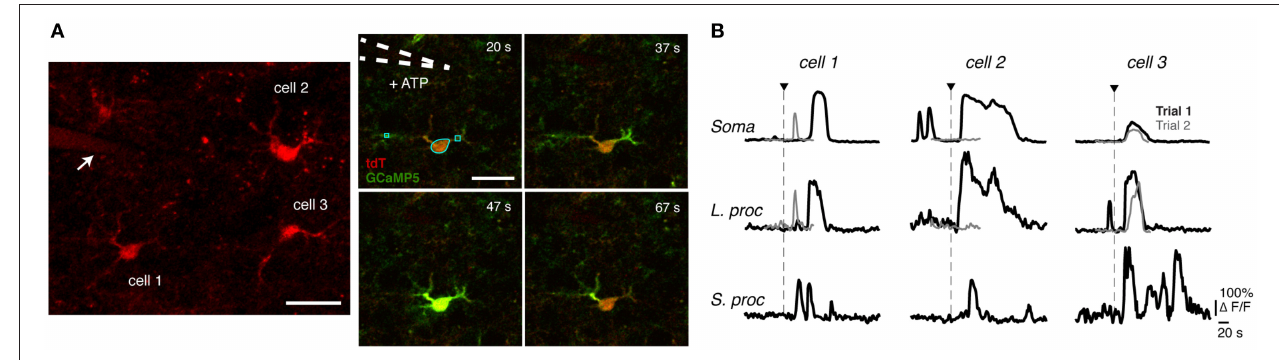
FIGURE 1 | Astrocyte Ca 2 + imaging and observed response variability. (A) (Left) A 12 µ m z-stack (centered around the imaging plane) of tdTomato indicating the location of three recorded astrocytes relative to the pipette (shown with arrow), which is also visible since it contains Alexa Fluor 594. The cell numbers correspond to those in (B) . (Right) Time series of intracellular Ca 2 + responses to focal application of ATP (application duration, 63ms) from a glass pipette (white dotted line) in a mouse acute brain slice. Examples of selected ROIs are shown for the soma, large processes, and small processes (cyan lines in the 20s frame). These ROIs correspond to the traces of cell 1, trial 1 in (B) . Scale bars, 20 µ m. (B) Example traces of simultaneous responses from different subcompartments of three cells (same cells shown in A ), in two different ATP application trials.